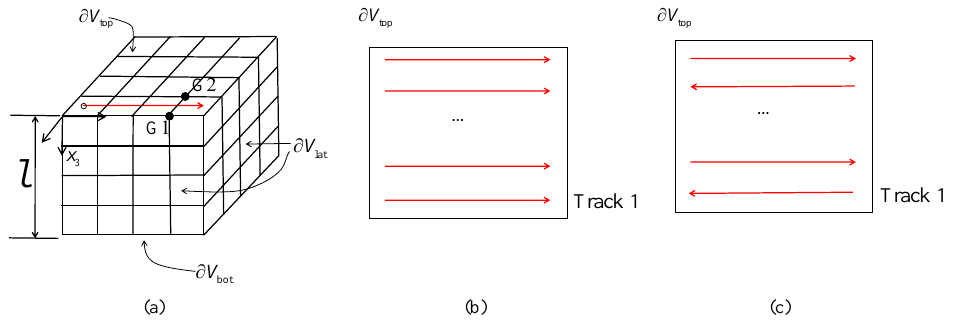
Figure 12. ( a ) A total of 21 laser tracks are applied on the top surface ∂ V top of the cube, which is discretized by 64 finite difference cells. The temperature histories of point G1 (1.5, 0, 0) mm and G2 (1.5, − 0.5, 0) mm are investigated. Two scanning strategies, ( b ) unidirectional and ( c ) alternating, are